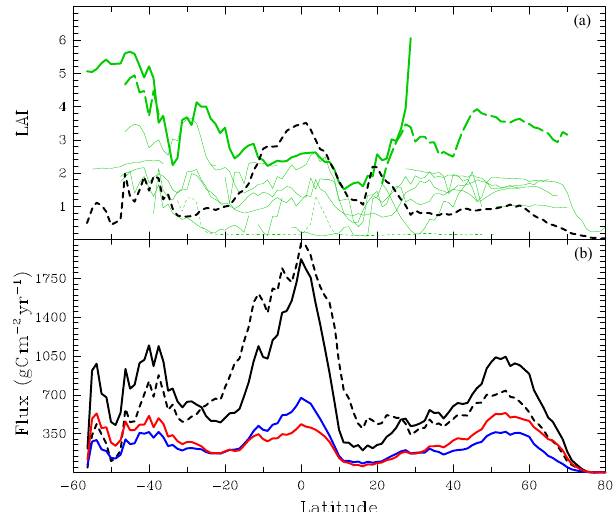
Figure 8. Zonal mean year 501–1000 leaf area index (a) and car- bon flux (b) in gCm − 2 yr − 1 . For ProgLAI, the LAI is zonally av- eraged over all tiles for each vegetation type separately (evergreen broadleaf trees, bold green; evergreen needleleaf trees, bold dashed green; C4 grass, dotted green; all other types, solid green). For Pres- LAI, the LAI is zonally averaged over all land grid cells (black, dash). Carbon fluxes are zonally averaged over all land grid cells, showing from ProgLAI, GPP (black solid), plant respiration (blue) and soil respiration (red) and from PresLAI, GPP (black, dashed).